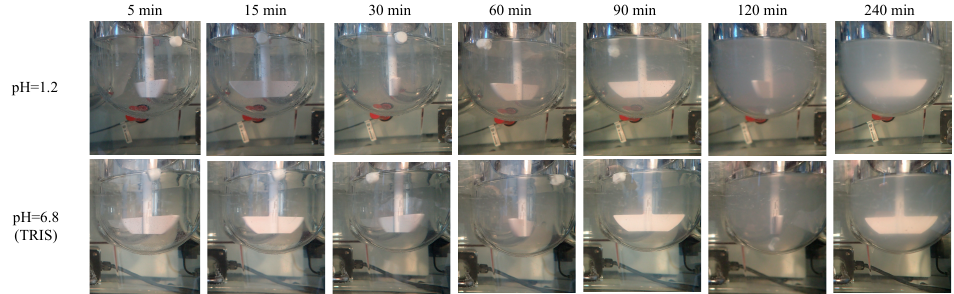
Figure 4. Visual tracking of the PVA-based carrier erosion in different media.